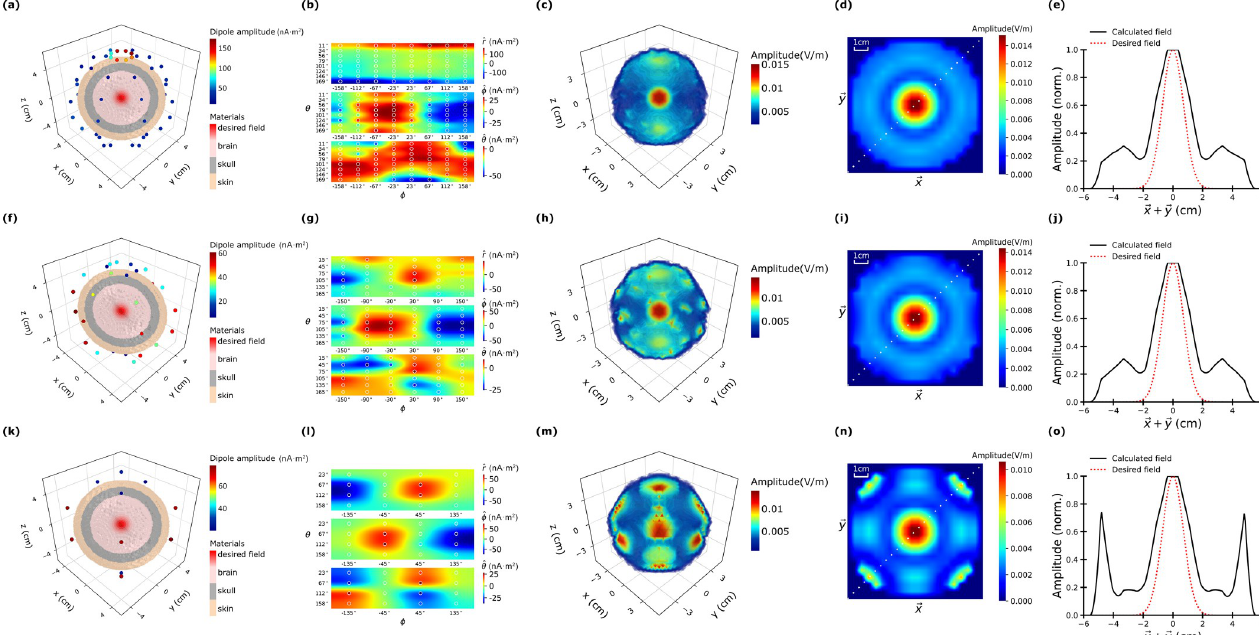
Fig 6. Results of MW focusing simulation in a 5 cm radius simplified brain model. The brain model consists of a brain-matter region with radius 3.2 cm at the center of a membranous skull region with 1 cm thickness, and a membranous skin region with 0.8 cm thickness. (a, f, k) show all the dipole locations and amplitudes (shown by color) superimposed on the brain model. The desired field intensity is also shown as the red region at the center of the brain. (b, g, l) are ^ the radial ( ^ r ^ ), declination ( ^ y ^ ), and azimuthal ( ; ^ ) components of the dipole amplitudes as function of the angles around the head ( θ and ϕ ). (c, h, m) and (d, i, n) are the electric field amplitude in 3D and a 2D cross-section. (e, j, o) is the field amplitude of optimized field and desired field as a function of the coordinate � ! ! � ! ! � ! ! � ! x ! ð x þ y Þ ffiffi þ y Þ ffiffi p . The coordinate ð p is along a diagonal direction shown by the white dotted line in (d, i, n). The three rows (counting from top to bottom) 2 2 correspond to the case of 64, 32, and 16 transmitting dipoles